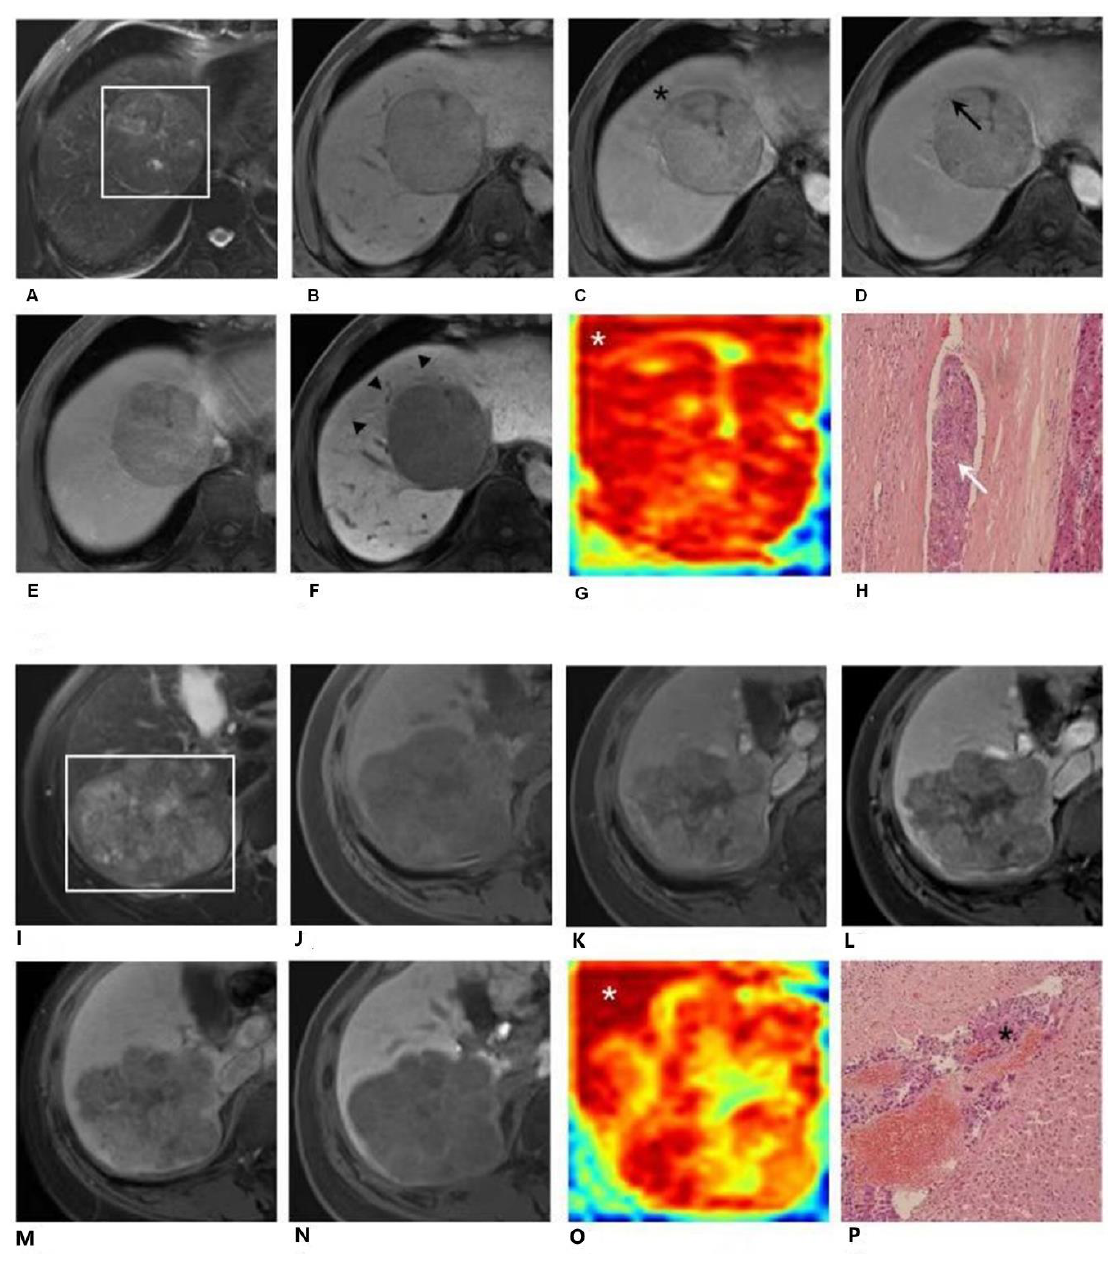
Figure 3. EOB-MRI images and EOB-MRI-based attention map. 3-1. Gadoxetic acid (EOB)-enhanced MR images ( A – F ) and the attention map ( G ) of a 57-year-old male patient. A 7.0 cm hepatocellular carcinoma (HCC) with histopathologically proven microvascular invasion (MVI) was detected in segment VIII. A distinctive high-risk area was detected on the attention map ( G ) along the tumor’s periphery (white star). This high-risk area could be confirmed radiologically by peritumoral enhancement (black star) of the arterial phase image ( C ), by interrupted capsule (black arrow) on the portal venous phase image ( D ) and by peritumoral hypointensity ( F , black arrowhead) on the hepatobiliary phase image ( G ). However, it was not captured on T2-weighted ( A ), T1-weighted pre-contrast ( B ), or transitional phase ( E ) images. This high-risk area was proved as MVI-positive by postoperative histopathologic examination with hematoxylin eosin (HE) staining at 100 × magnification ( H , white arrow). EOB-MR images ( I – P ) and the attention map ( O ) of a 51-year-old female patient. An 8.6cm HCC with a histopathologically proven MVI was detected in segments VI and VII. A distinctive high-risk area was detected on the attention map ( O ) along the tumor periphery (white star). However, this high-risk area was not captured on T2-weighted ( I ), T1-weighted pre-contrast ( J ), arterial phase ( K ), portal venous phase ( L ), transitional phase ( M ) or hepatobiliary phase ( N ) images. This high-risk area was proved as MVI-positive by postoperative histopathologic examination with hematoxylin eosin (HE) staining at 100 × magnification ( P , black